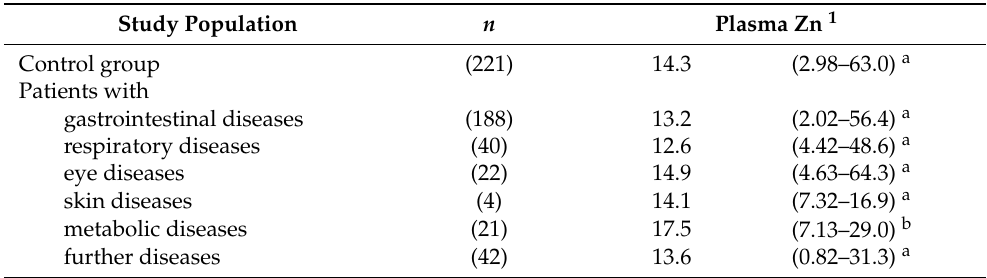
Table 2. Plasma Zn concentrations (µmol/L) of the control group and the subgroups of the horses and ponies with internal diseases. Median (minimum–maximum).